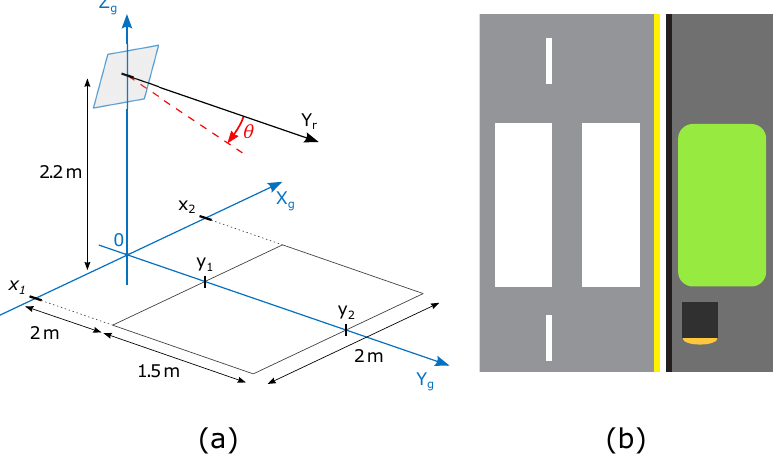
Figure 11. ( a ) Experimental setup. ( b ) Illustration of observation area next to a zebra crossing. To simulate walking on a sidewalk, participants in our experiment always entered by either of the two short edges, depending on the walking direction, and were moving in a tangential direction from the point of view of the radar. Participants who were passing by also exited the observation area by either of the short edges. In contrast, participants who stopped to cross the street exited the observation area by the longer edge as if it faced the zebra crossing.